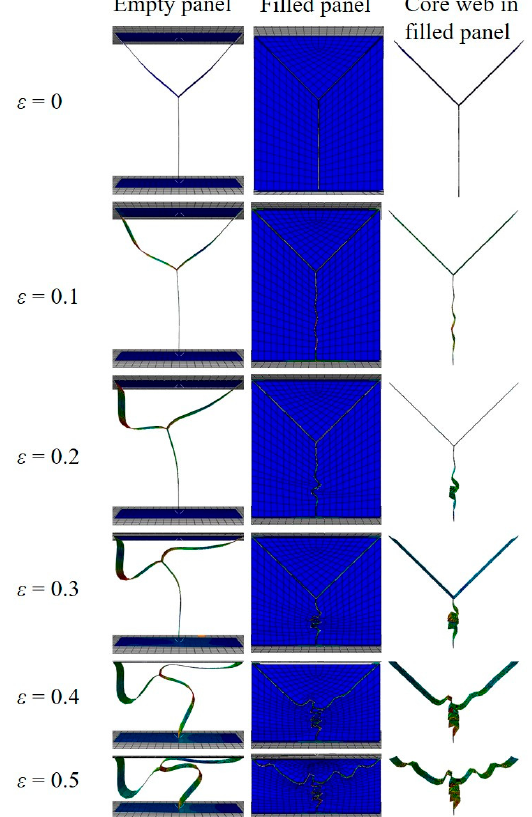
Figure 8. Simulated deformation modes of empty and aluminum foam-filled Y-shape cored sandwich panels under different compressive strains. The deformation of Y-shaped core member in the foam-filled panel shows more complicated deformation modes due to aluminum foam filling, t = 0.41 mm.